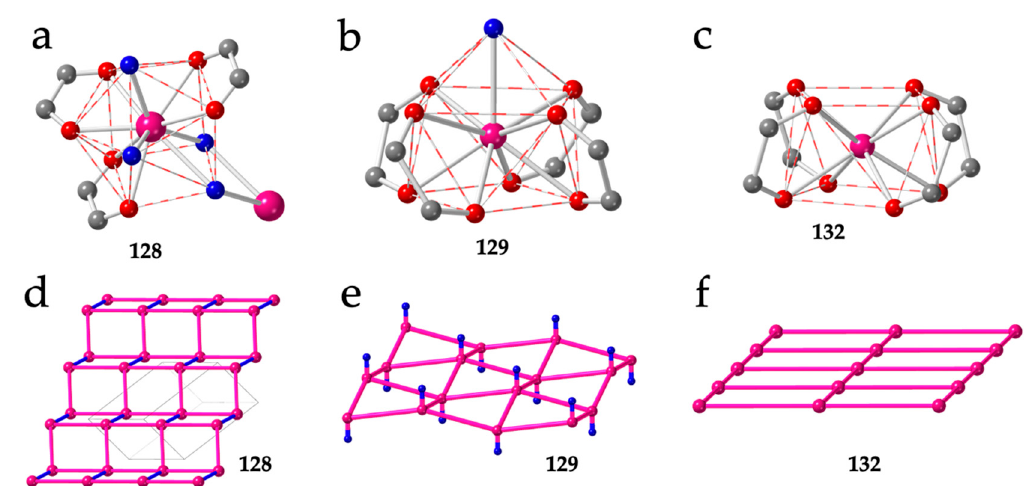
Figure 16. ( a ) Coordination environment of the La(III) ions in compound 128 . ( b ) Coordination environment of the Dy(III) ions in compound 129. ( c ) Coordination environment of the Dy(III) ions in compound 132 . ( d) Schematic view of the layered structure in compound 128 . ( e ) Schematic view of the corrugated layers in compound 129 . ( f ) Schematic view of the planar layers in compound 132 . Pink and blue lines represent the anilato and double aquo bridges, respectively. Colour code: Ln = pink, C = grey, O anilato = red and O water = blue.